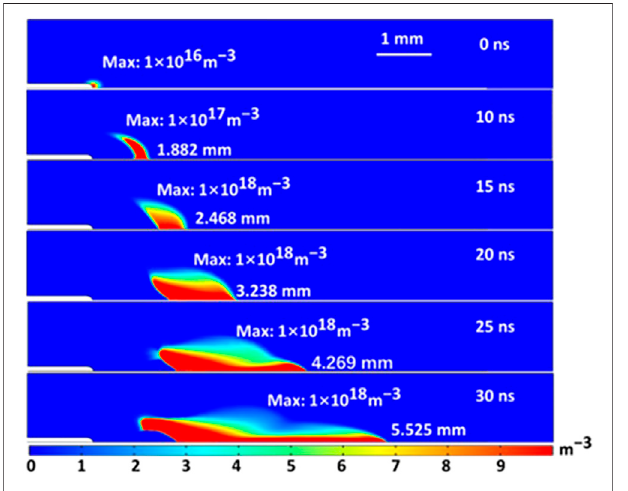
FIGURE 12 | Electron density distribution on thinner layer of graded permittivity.